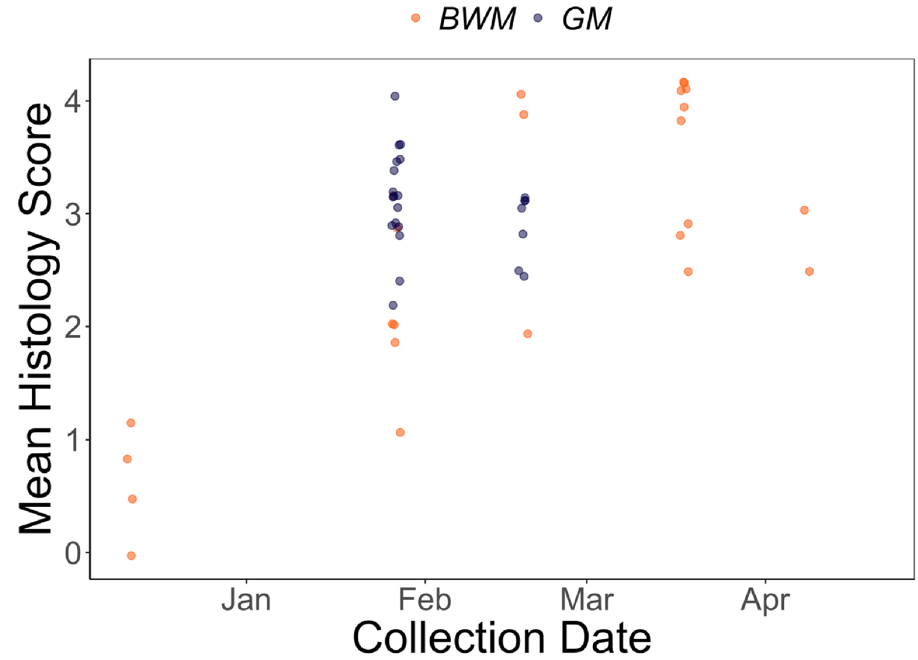
Figure 2. Mean WNS histologic severity scores of dead or moribund bats collected from BWM and GM. Scores are averaged across body surfaces examined (wing, ear/muzzle). Scores were graded as 0—no fungi suggestive of WNS, 1—superficial and limited but suspicious of early WNS with hyphae in keratin and randomly into epidermis, but not yet forming distinctive cupping or dense packets, 2—More extensive superficial infection with epidermal cupping packed with hyphae diagnostic of WNS, 3—More severe fungal infection with tissue invasion including epidermal cupping packed with hyphae diagnostic of WNS, 4—Severe infection with tissue and wing damage worse than